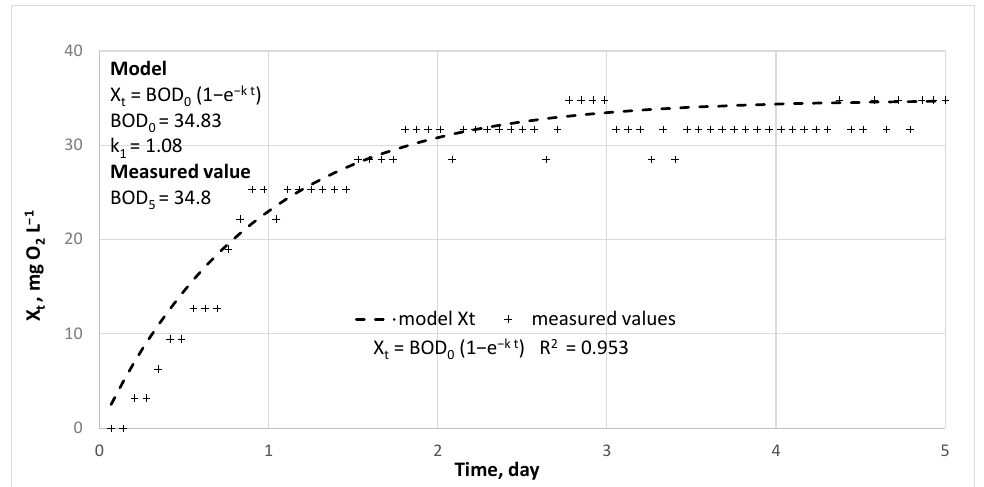
Figure 6. Value of biochemical oxygen consumption in rejected water, WWTP 2, sample 1.